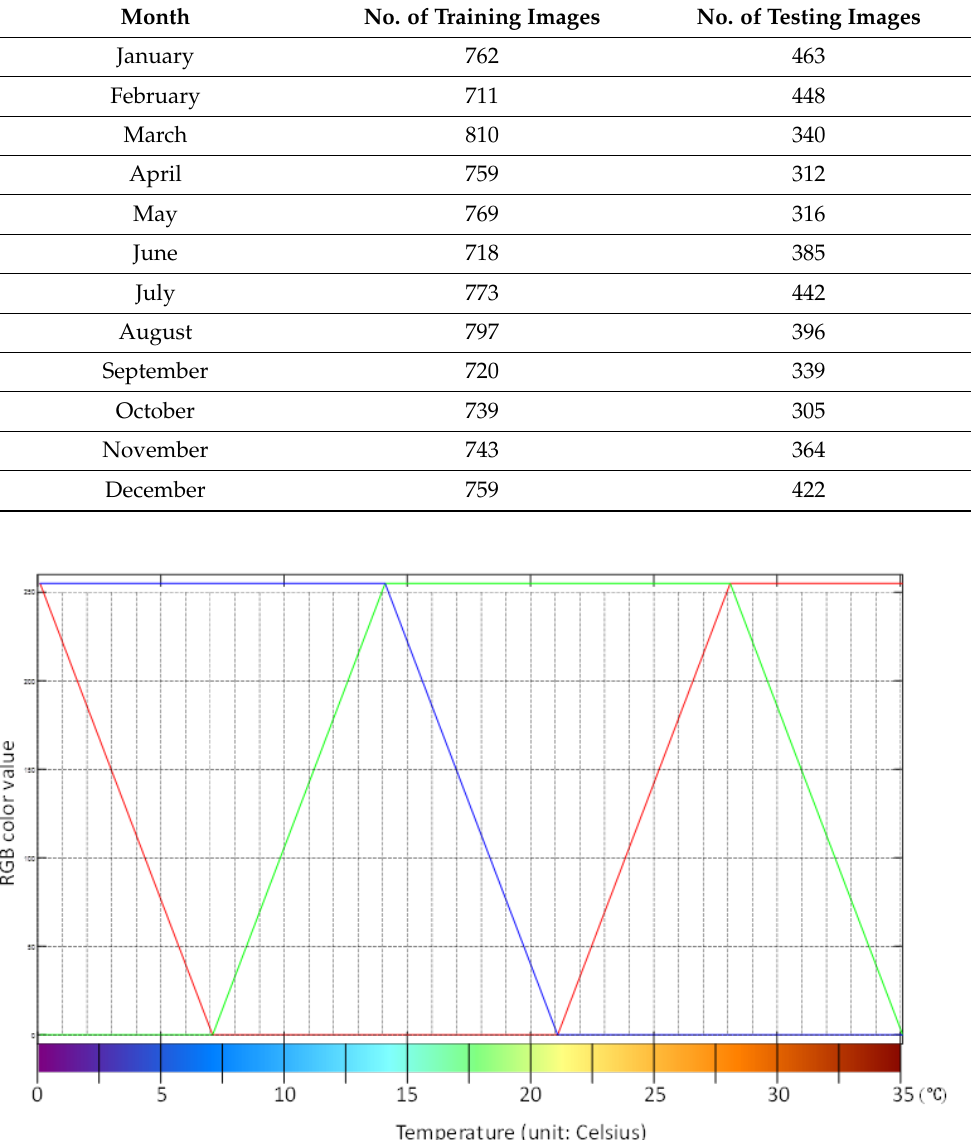
Figure 6. Matching graph that maps RGB color values to the corresponding temperature value to convert an original ocean satellite image into the temperature value matrix.